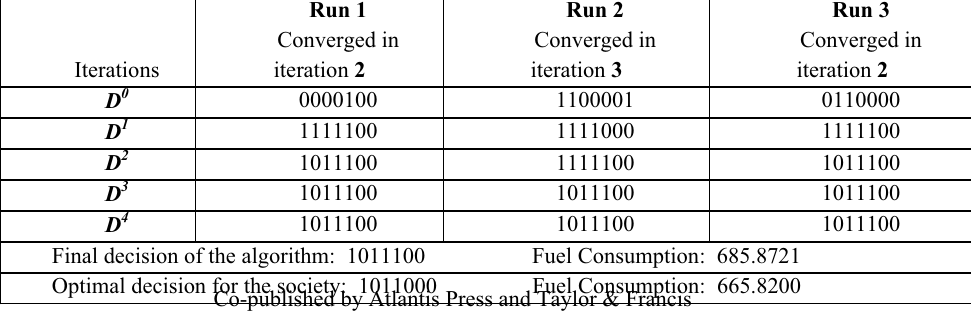
Final decision of the algorithm: 0011110 Optimal decision for the society: 0011100 Table 6. Progress of the proposed algorithm for second set of fuels in problem case 2 in three different runs. Run 1 Converged Iterations